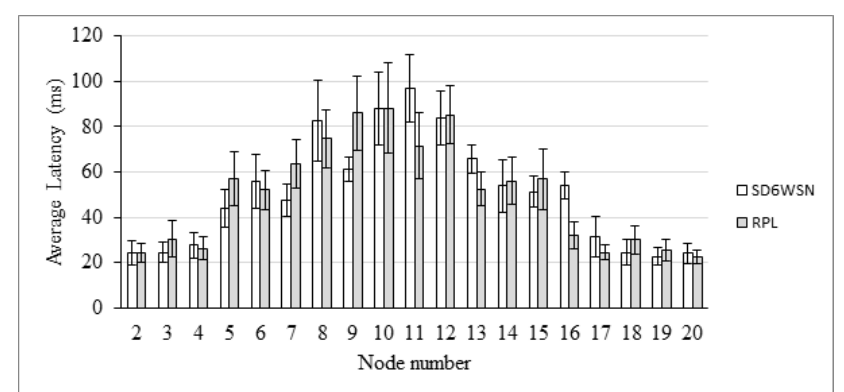
Figure 18. Average latency for the 25 m-range scenario.